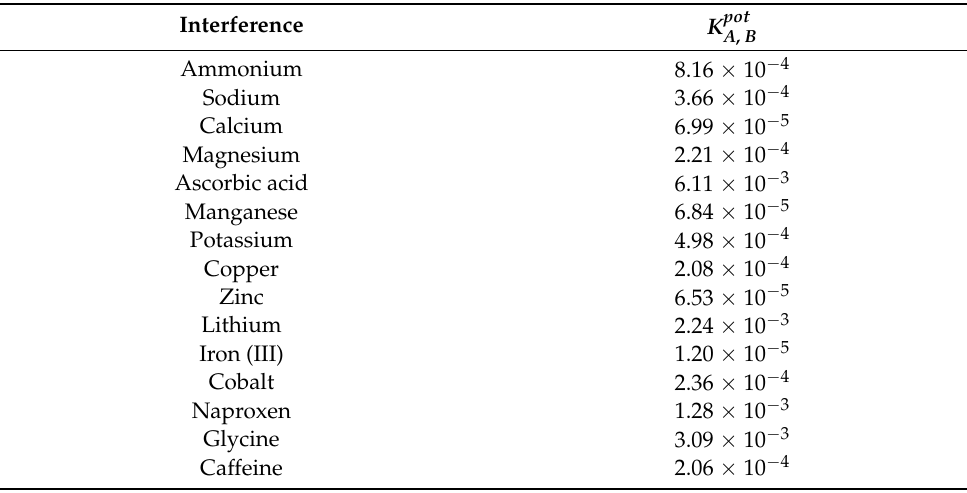
Table 4. Potentiometric selectivity coefficients of the new PM